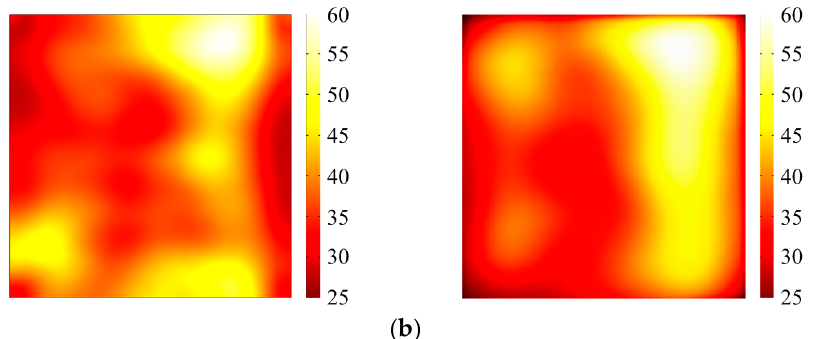
Figure 6. Comparisons of experimental and simulated spatial temperature profiles of potatoes subjected to 12 s heating in a 300 W microwave oven (the simulation results are on the left, and the experimental results are on the right (unit: °C): ( a ) the turntable is composed of PE; and ( b ) turntable is composed of PE and alumina.